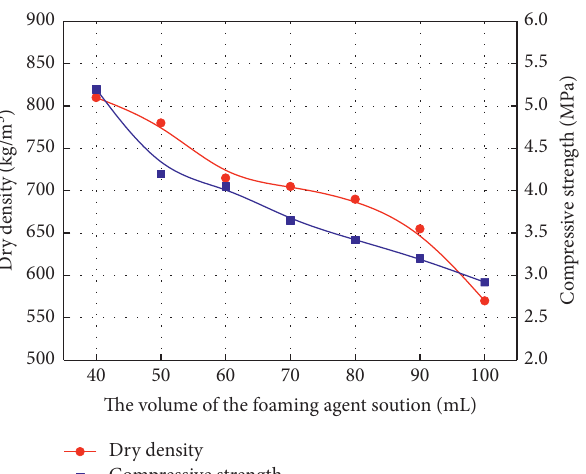
Figure 12: Dry density and compressive strength of foamed concrete prepared with different volumes of foaming agent solution.